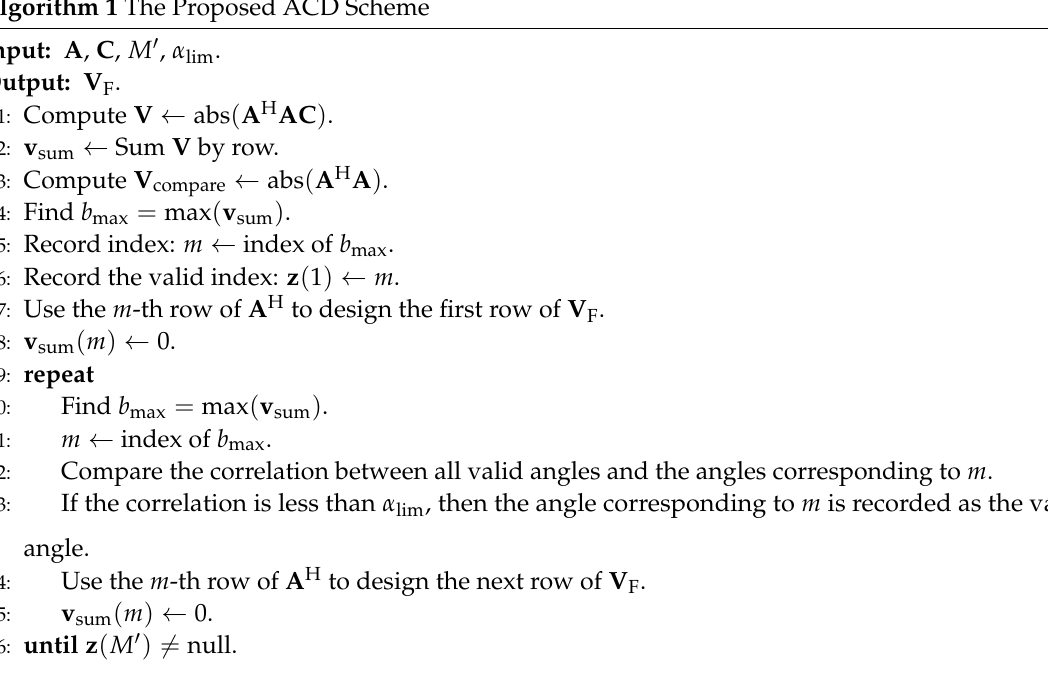
Algorithm 1 The Proposed ACD